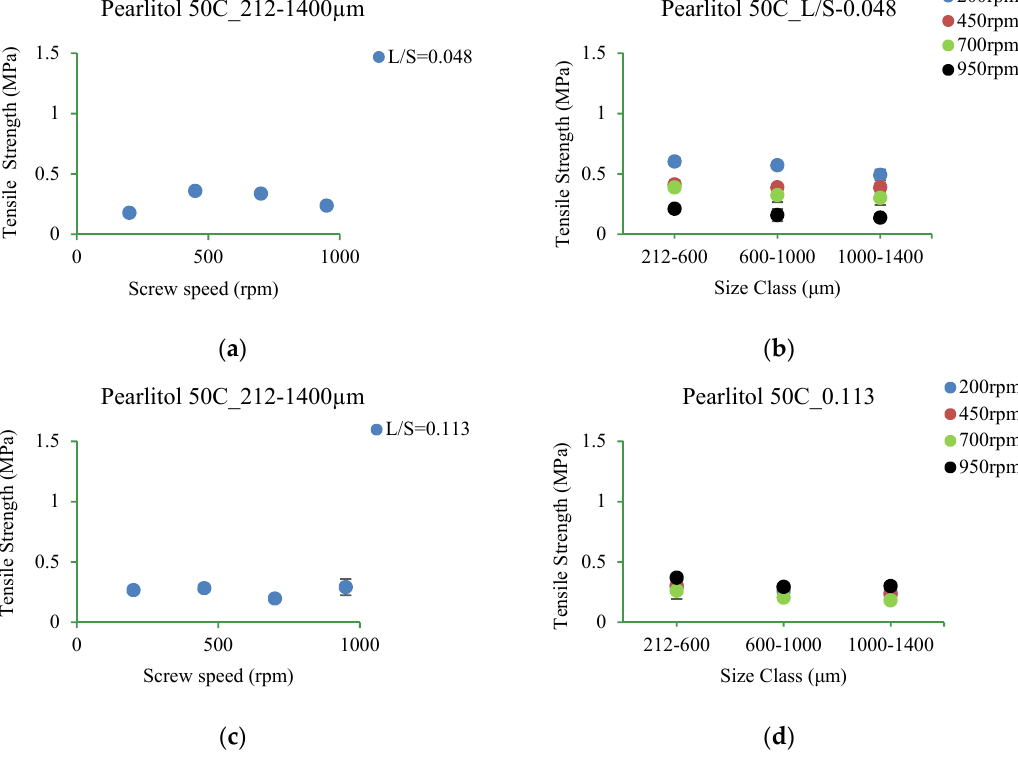
Figure 18. Tensile strength of tablet of granules at different size classes of Pearlitol 50C. ( a ) 212–1400 µ m at L/S of 0.048; ( b ) 212–600 µ m, 600–1000 µ m, 1000–1400 µ m at L/S of 0.048; ( c ) 212–1400 µ m at L/S